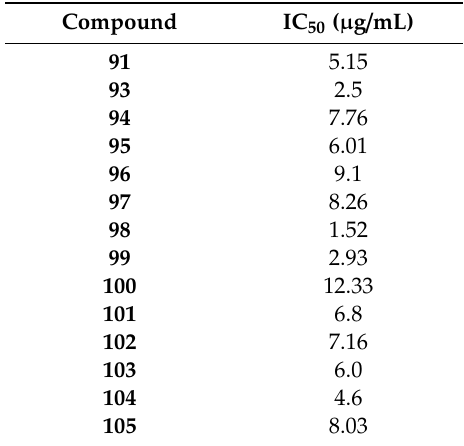
Table 22. Anti-plasmodial IC 50 values for compounds 91 and 93 – 105